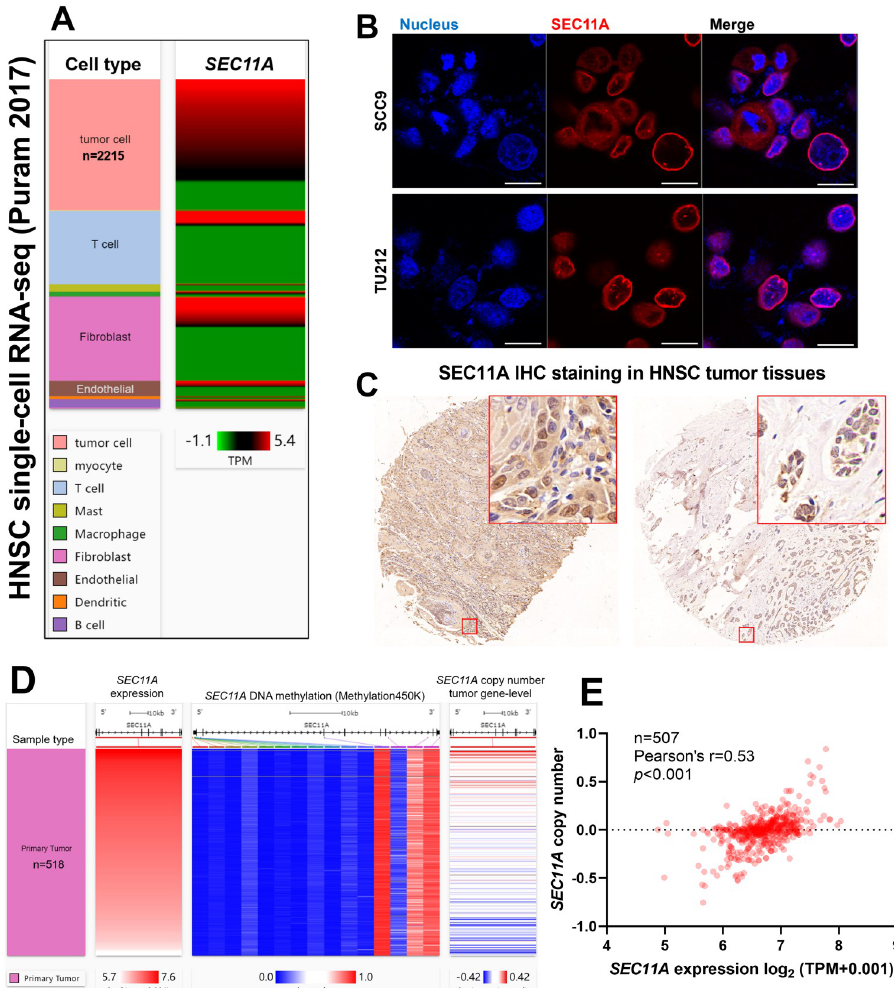
Fig 3. Analysis of SEC11A expression in the tumor microenvironment. A. The expression profile of SEC11A in different cell types in Puram 2017’s single-cell dataset. B. Immunofluorescent staining was conducted to show SEC11A localization in SCC9 and TU212 cells. C. Representative images of SEC11A protein expression (IHC staining) in primary head and neck squamous cell carcinoma tissues. D. A heatmap showing the correlation among SEC11A expression, SEC11A gene locus methylation, and gene-level SEC11A copy number in primary head and neck squamous cell carcinoma cases in TCGA. E. A plot chart showing the spearman correlation between SEC11A gene expression and gene-level copy